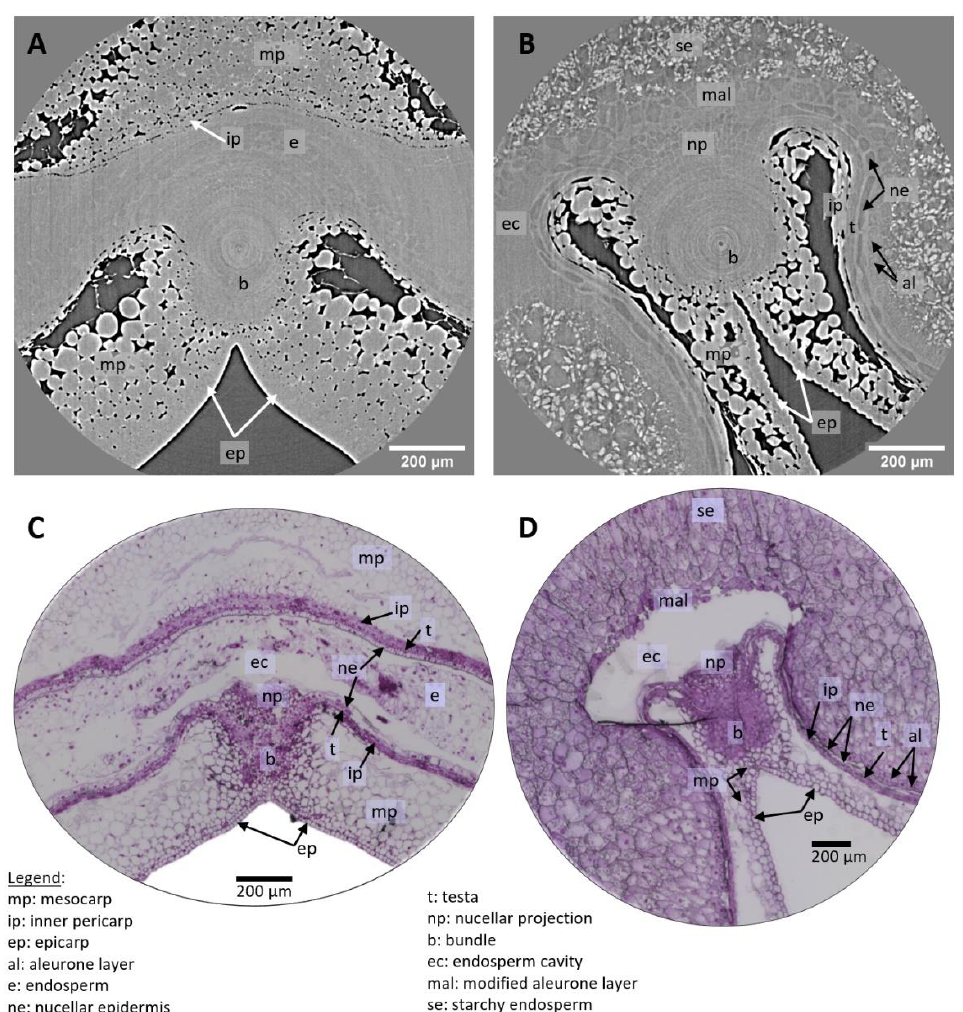
Figure 5. High-resolution images of grain tissues. ( A , B ) XY slices of 3D tomography images of a wheat grain at 100 °DAA and 250 °DAA in the crease region. ( C , D ) Microscopy images of wheat grain at 100 °DAA and 250 °DAA (Toluidine Blue O stained) in similar regions as ( A , B ). On the tomography images, individual cells are clearly distinguished in several